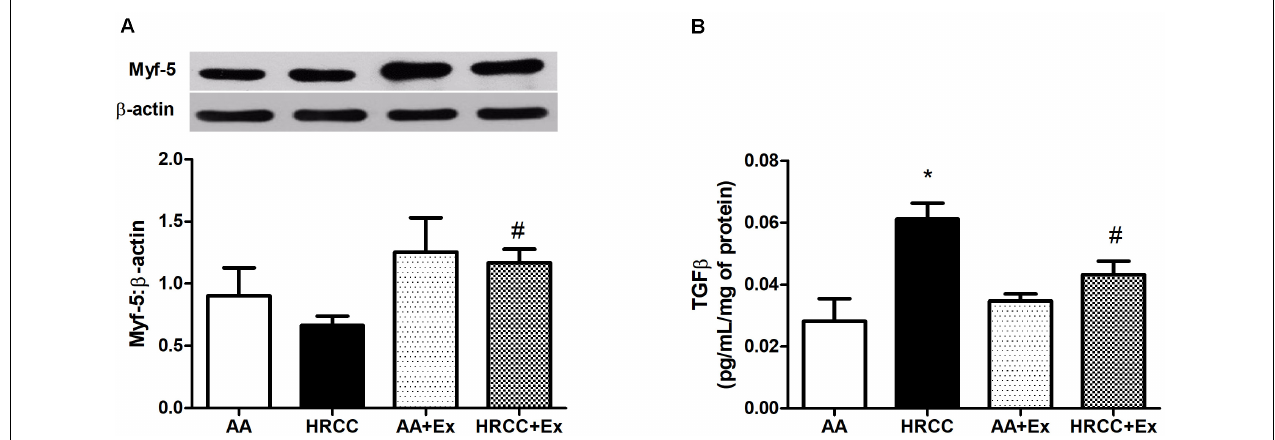
FIGURE 2 | Effect of combined exercise on parameters of muscle remodeling in quadriceps of mice exposed to hand-rolled cornhusk cigarette (HRCC) smoke. The content of myogenic factor 5 (Myf5) (A) was normalized to β -actin, and the production of transforming growth factor beta (TGF β ) (B) was normalized to the total amount of protein. Data are expressed as mean and standard error of the mean and were analyzed statistically using two-way ANOVA, followed by the Newman–Keuls test. The groups were considered different when p ≤ 0.05* (difference in relation to the ambient air, # difference in relation to